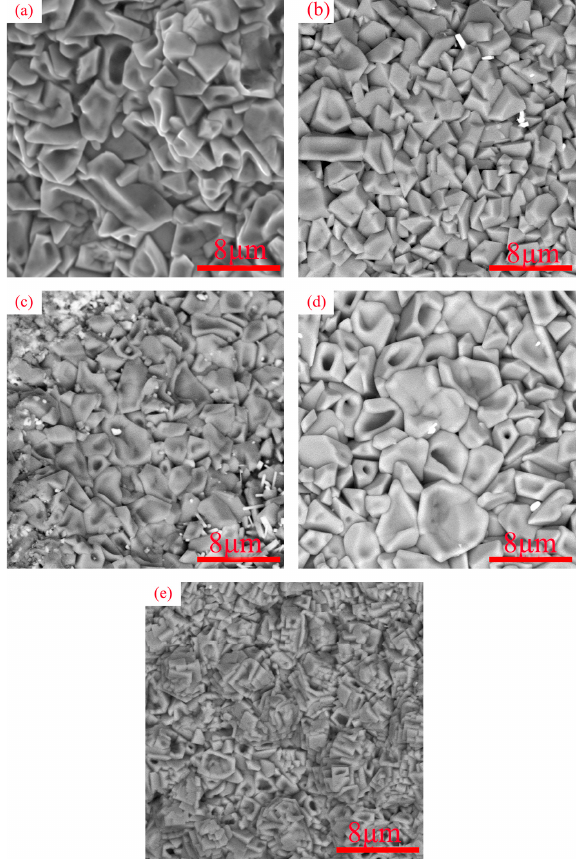
Figure 7. SEM of surface oxidation of WVTaTiCr x RHEA coating: ( a ) Cr 0 ; ( b ) Cr 0.25 ; ( c ) Cr 0.5 ; ( d ) Cr 0.75 ; ( e ) Cr 1 .